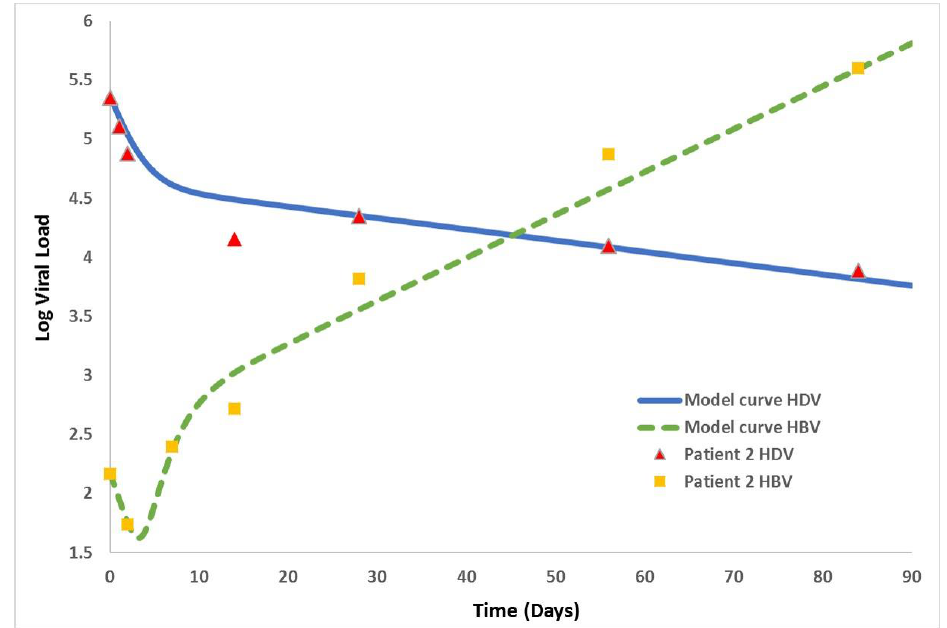
Figure 3. Patient 2 HDV/HBV levels after initiation of LNF treatment (first 84